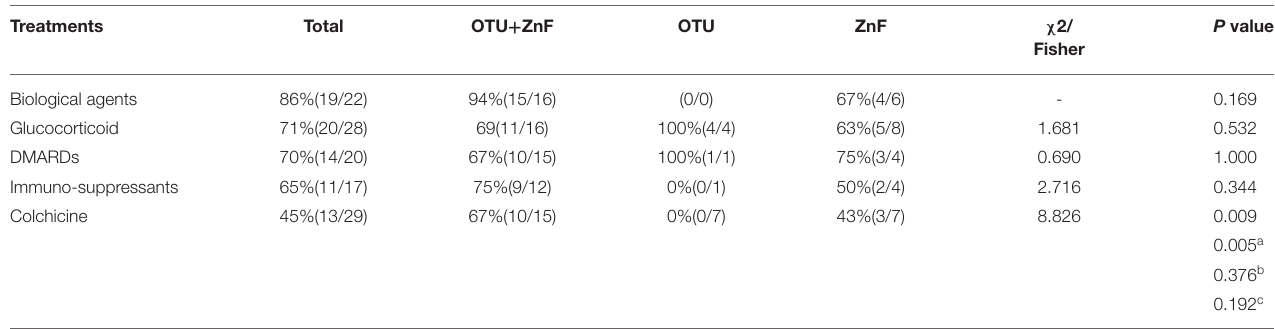
TABLE 3 | Univariate analysis of treatment response of patients with HA20 based on types of A20 disruption. Treatments Total